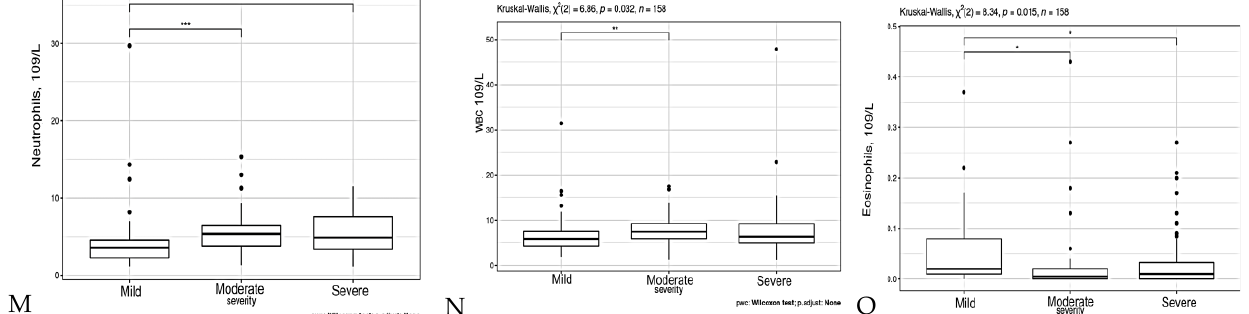
Figure 1. PLA2 ( A ), IL-6 ( B ), APTT ( C ), ACT ( D ), CRB ( E ), D-dimer ( F ), ferritin ( G ), LDH ( H ), procalcitonin ( I ), and GFR ( J ) levels, and hematocrit ( K ), lymphocytes ( L ), neutrophils ( M ), leucocytes ( N ), eosinophils ( O ) in patients depending on the severity of the COVID-19 infection. The results are presented as the arithmetic means ± standard deviation. The significance levels evaluated as * p < 0.05; ** p < 0.01; *** p < 0.001; and **** p < 0.0001.